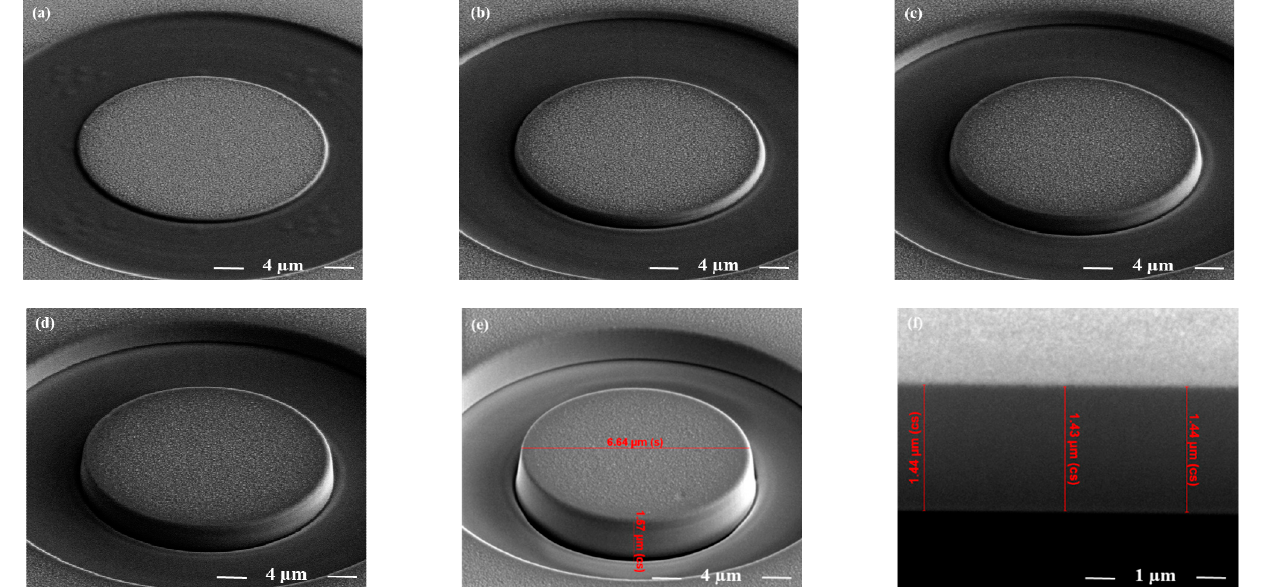
Figure 2. Representative images from ( a – e ) step-by-step milled pillar showing the semi-automatic milling procedure (scale bar only in figure ( e )), and cross section ( f ), highlighting the thin film thickness.